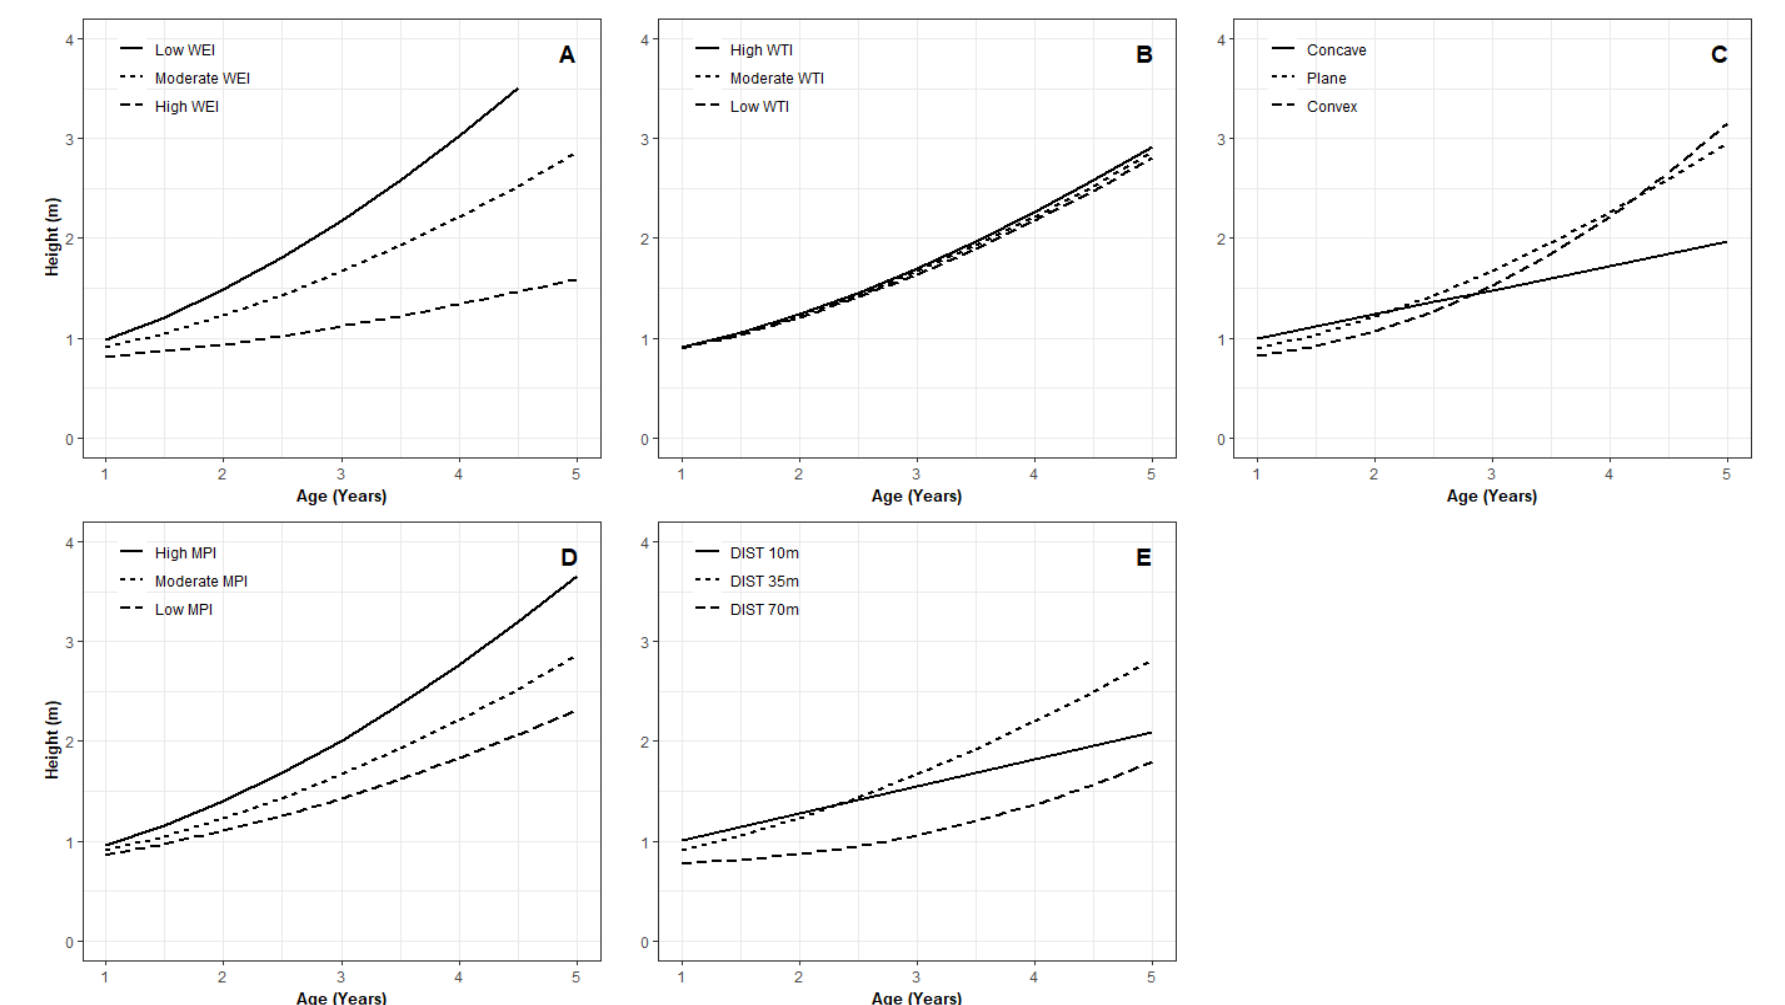
Figure 5. Topographic effects of E. bosistoana height growth at site C: ( A ) Effect of wind exposure index, ( B ) effect of wetness index, ( C ) effect of topographic position index, ( D ) effect of morphometric protection index, and ( E ) effect of distance from the top ridge.